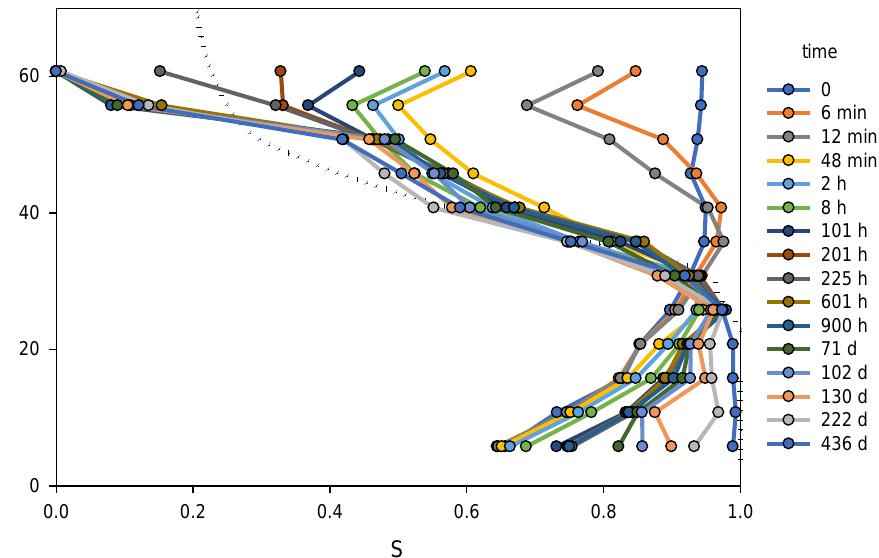
Figure 5. Elevation above the water table (z) vs. saturation (S) measured over 436 days from the start of the imbibition experiment. The dotted line corresponds to a previously measured P c – S relationship for the F45